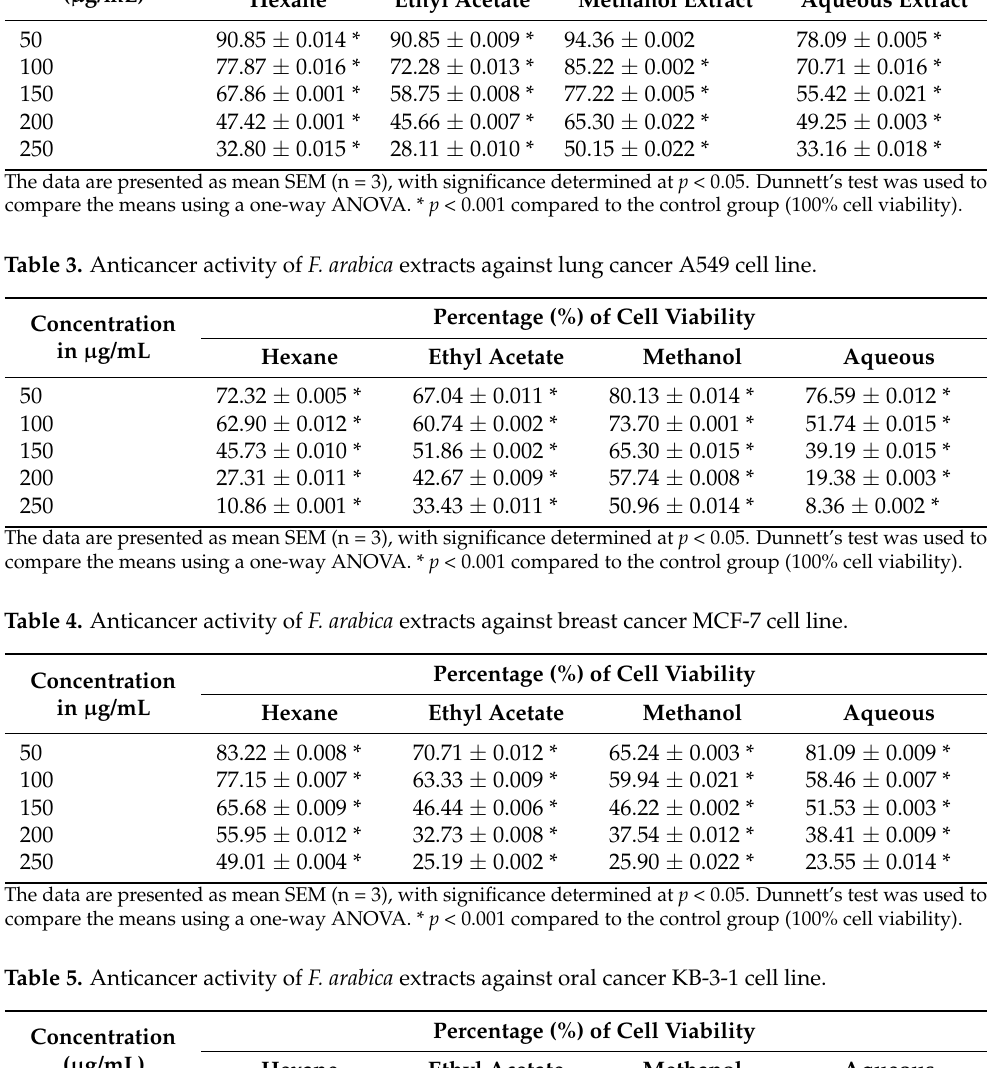
Table 2. Cytotoxicity of different solvent extracts of F. arabica against L929 cell line. Concentration ( µ g/mL)